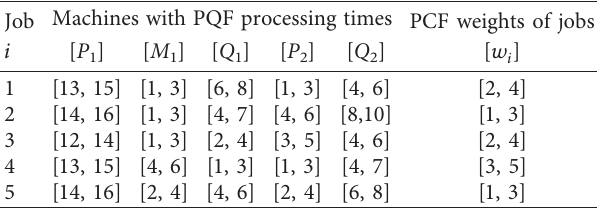
Table 3: Approximate closed interval processing times.